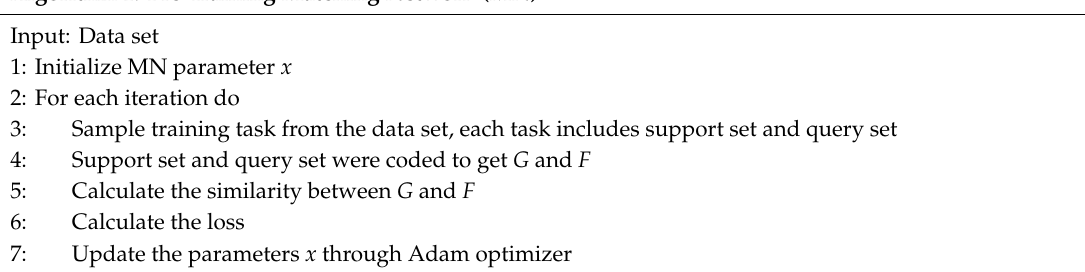
Algorithm 1. Pre-Training Matching Network